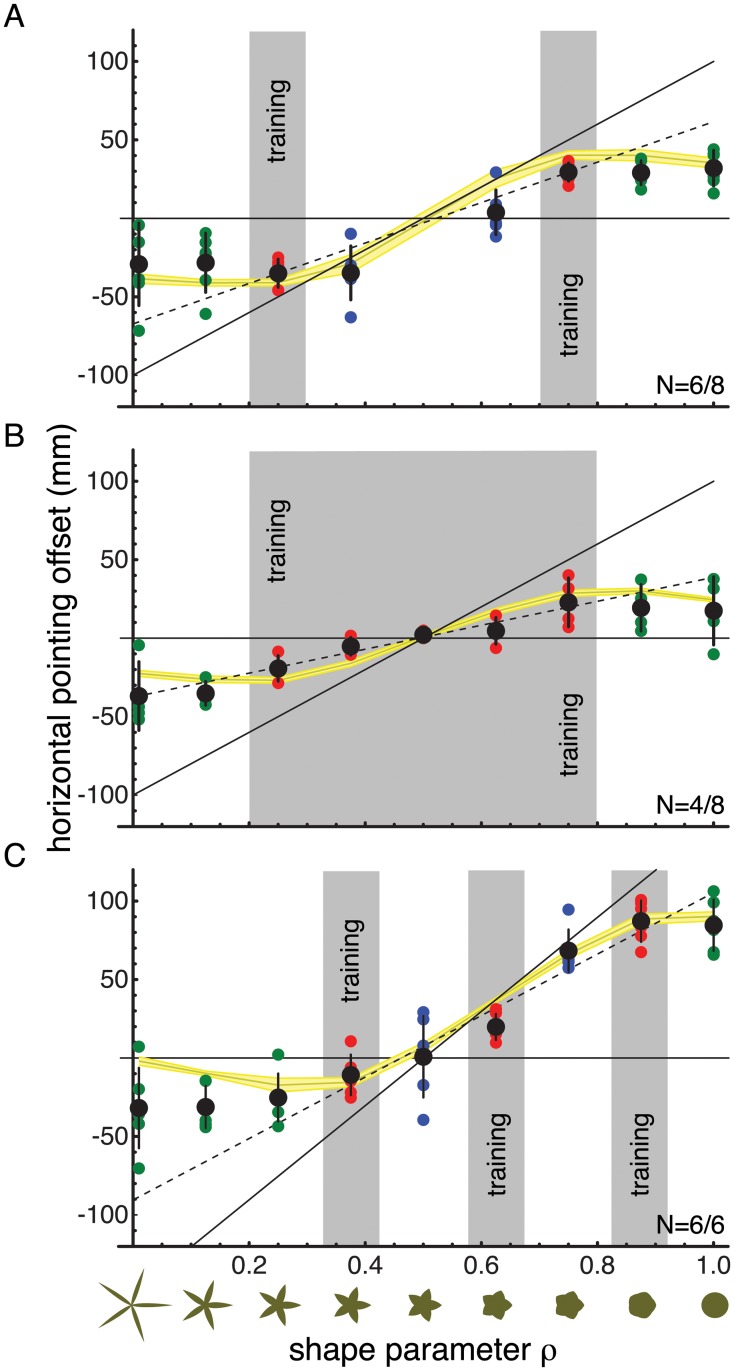
Generalisation results for Experiments 2 and 3.A) Results for the 2-Pair Condition of Experiment 2. B) Results for the 5-Pair Condition of Experiment 2. C) Results for Experiment 3 in which 3 training pairs were used. In each graph the numbers in the lower right corner indicate how many participants learned and the total number of participants for that condition. Axes and colour coding are the same as for Fig. 3. The results indicate that extrapolation of learning does not occur in a linear manner. The Mixture-of-Kalman-Filters performs better at capturing the generalisation results.